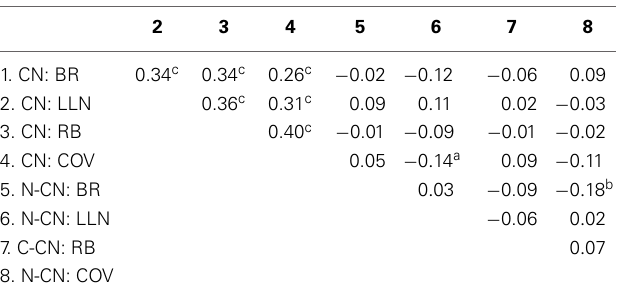
Table 2 | Correlations between responses on the conflict and no-conflict